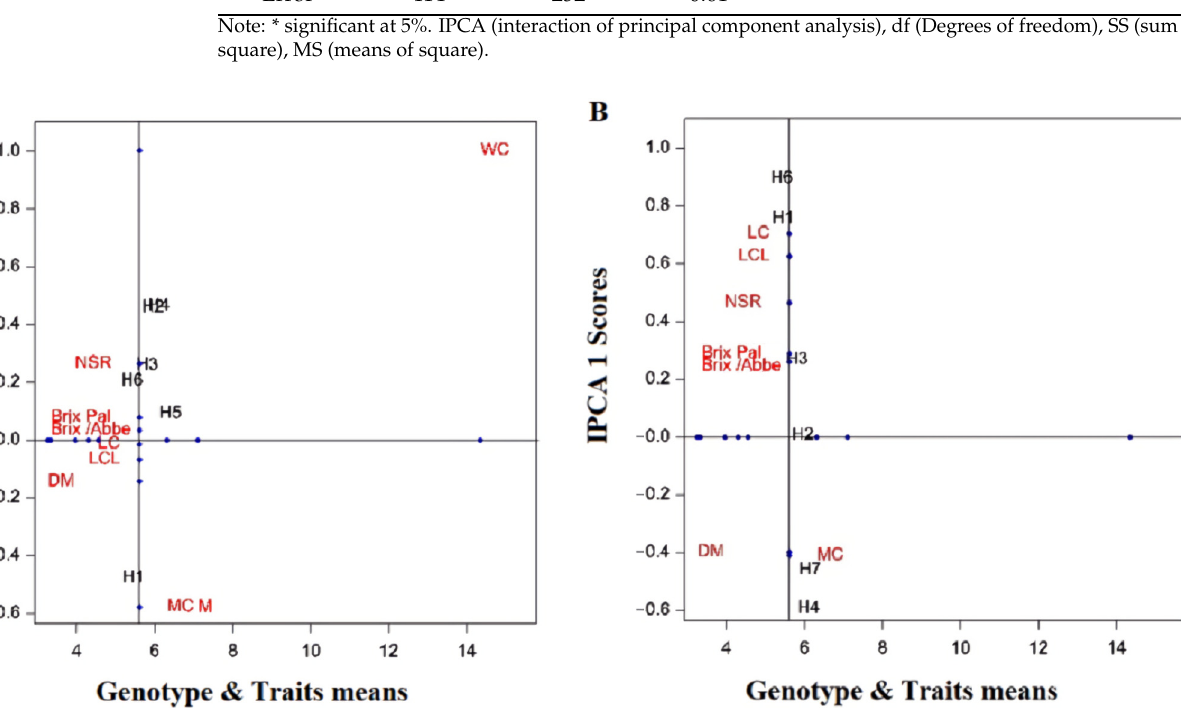
Note: * significant at 5%. IPCA (interaction of principal component analysis), df (Degrees of free- dom), SS (sum of square), MS (means of square).